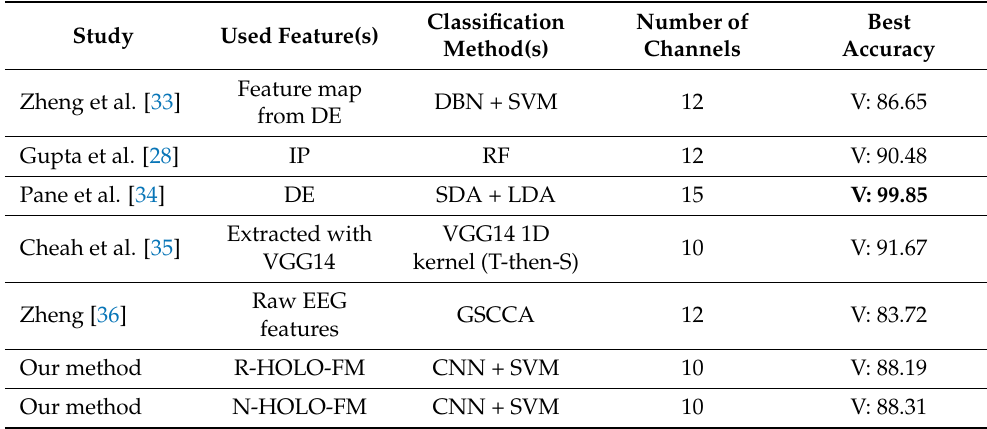
Table 7. Comparison with other studies with reduced channel set on SEED